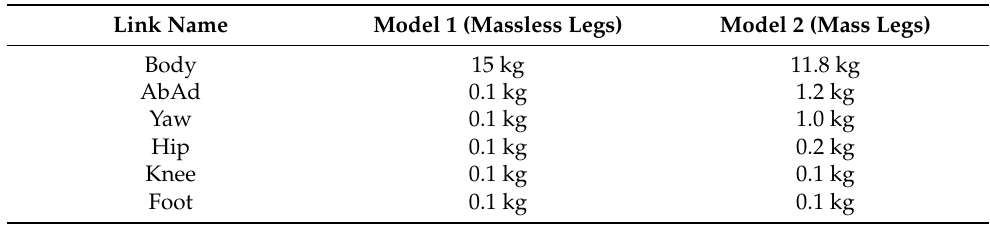
Table 1. The mass parameters of two models.